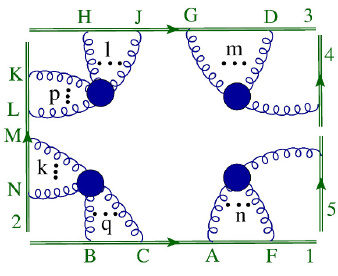
Figure 19. Diagram of the general Cweb W (1 , 1 , 1 , 1)